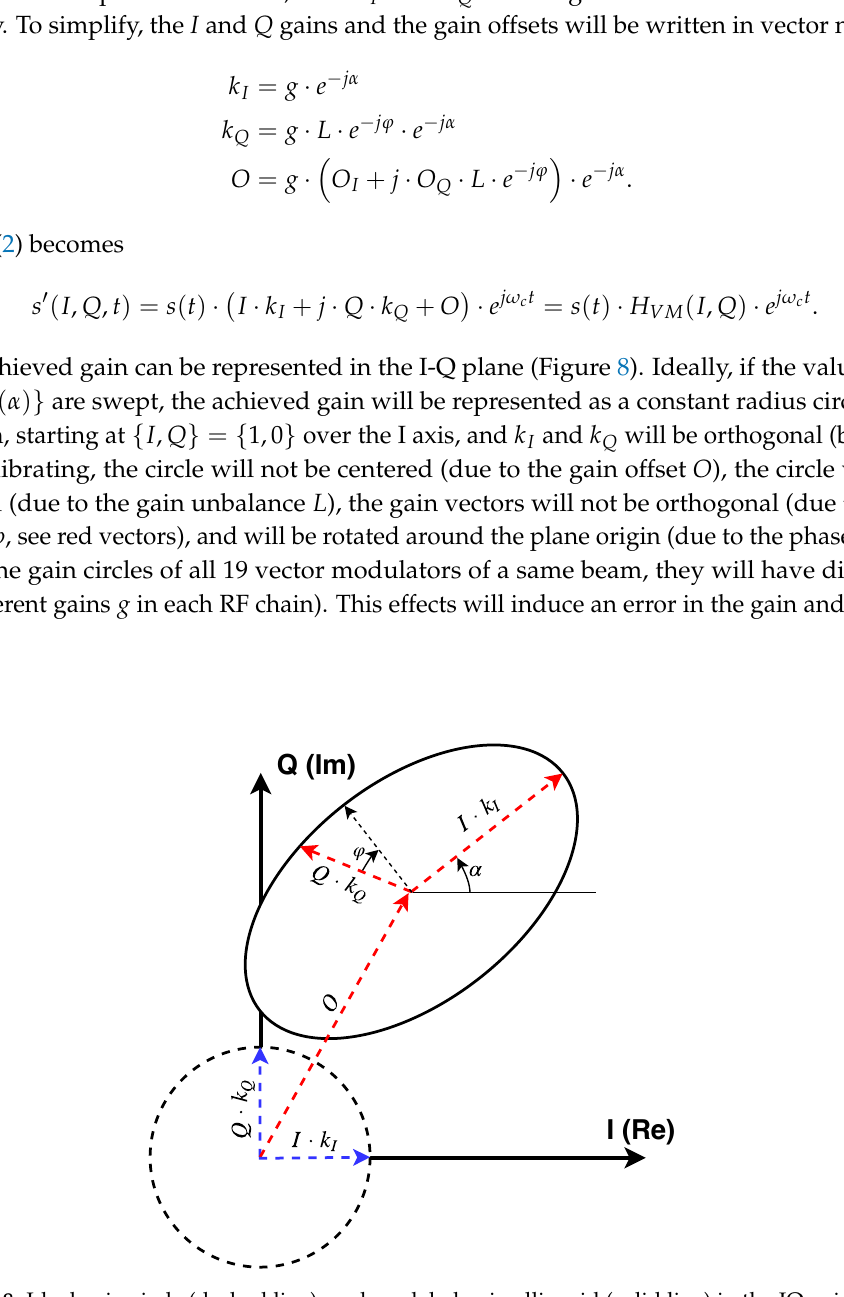
Figure 8. Ideal gain circle (dashed line), and modeled gain ellipsoid (solid line) in the IQ gain